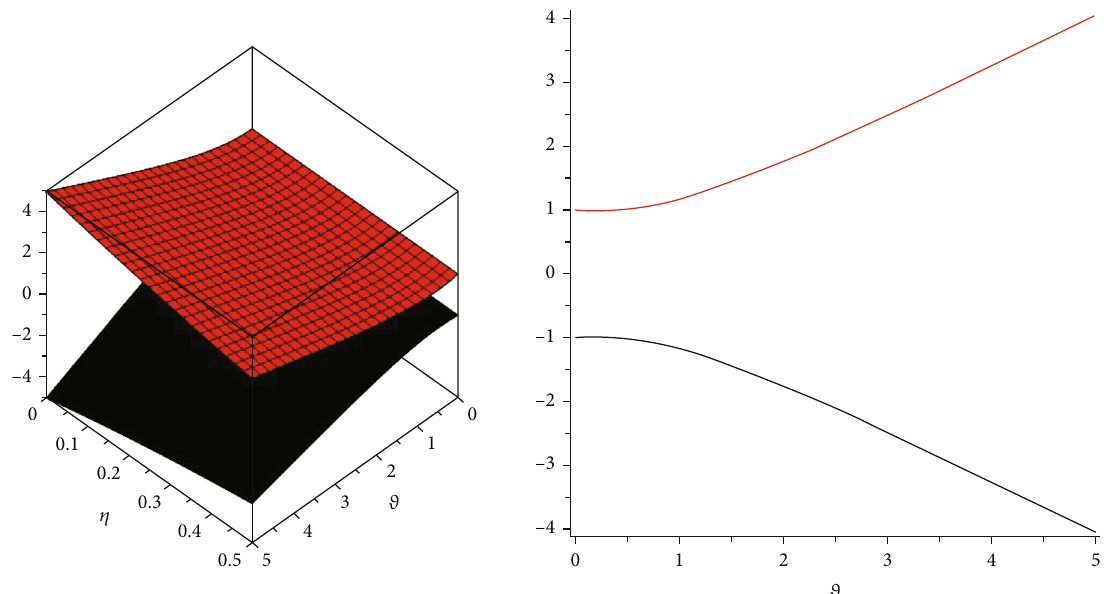
Figure 1: The fi rst fi gure shows the 3D fuzzy upper and lower branches of analytical solution at ρ = 1 and the 2nd fi gure shows the 2D fuzzy fi gure at ϱ = 1 .